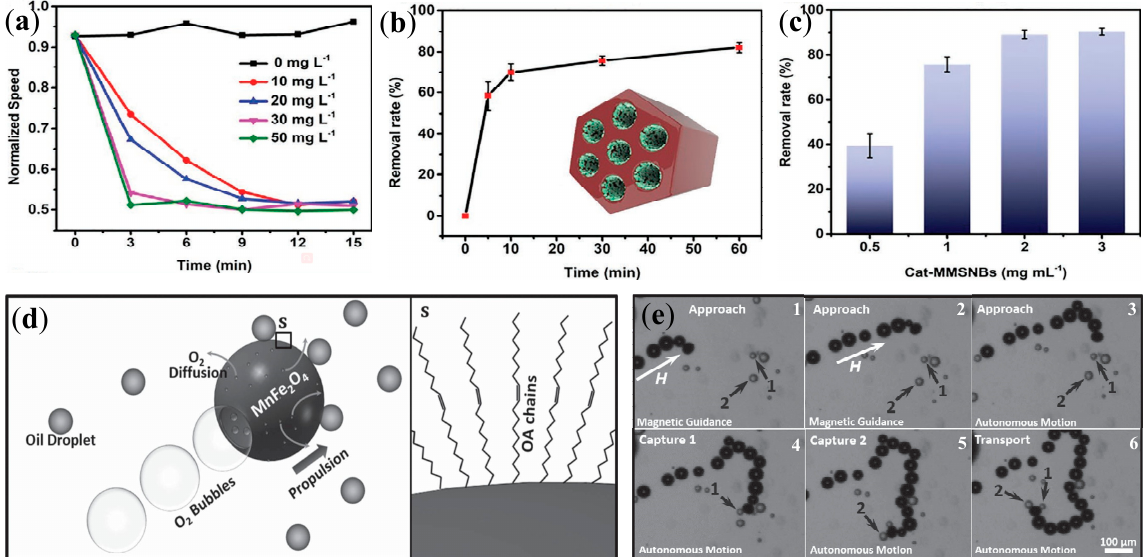
Figure 9. ( a ) Motion velocity of nanobottle motors changes with time in the solution at different concentrations of heavy metal ions. ( b ) Removal rate of mesoporous silica nanobottle motors in Cu 2+ solution. ( c ) Removal rate of Cu +2 at concentration of catalase-propelled magnetic mesoporous silica nanobottle (Cat-MMNB) motors of 0.5, 1, 2, 3 mg mL − 1 . Reprinted with permission from Ref. [106]. Copyright 2021, copyright Wiley-VCH GmbH. ( d ) Nanobottle motor absorbs oil droplets through hydrophobic surface. ( e ) Nanobottle motor approaches, captures and delivers oil droplets (1 and 2) under magnetic guidance and autonomous motion. The scale bar is 100 µ m. Reprinted with permission from Ref. [38]. Copyright 2015, copyright Wiley-VCH